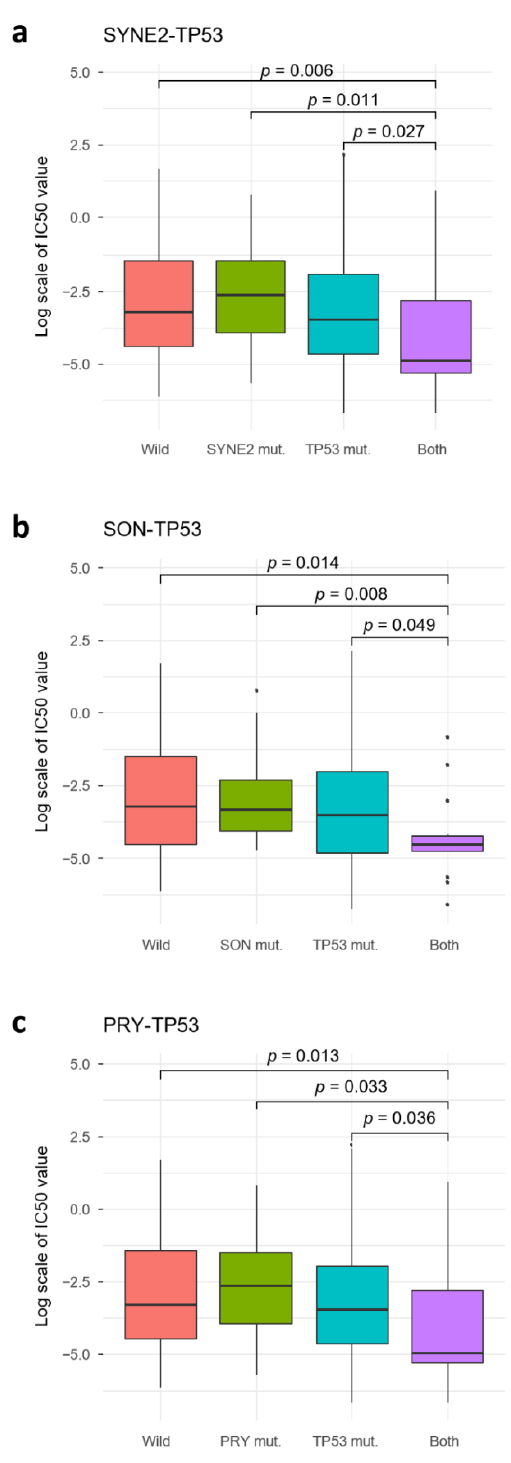
Figure 5. ( a–c ) Three genes that exert a synergistic effect on TP53 responses to paclitaxel. When the SYNE2, SON, and PRY genes digenically disrupt TP53 , the IC 50 value of paclitaxel decreases sig-